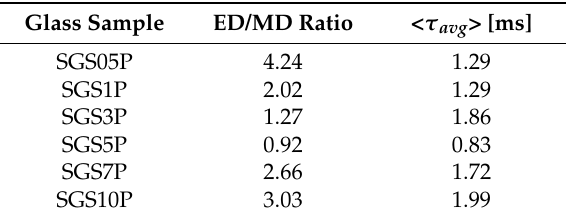
Figure 3. The luminescence decay of 5 D 0 energy level of europium ions in fabricated SGSxP glasses. Table 1. The ED/MD transition ratio, lifetimes ( τ 1 and τ 2 ) and average lifetime < τ avg > of 5 D 0 level of Eu 3+ ions.